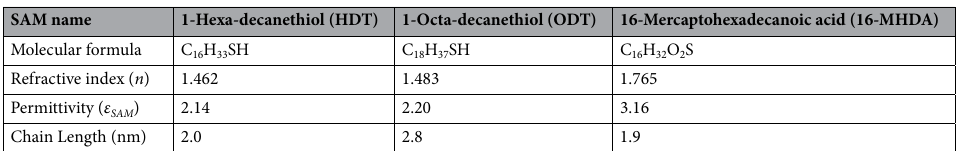
Table 1. The molecular formula, refractive index, permittivity, and chain length of the SAMs used in this study. Values are taken from Refs 14–17